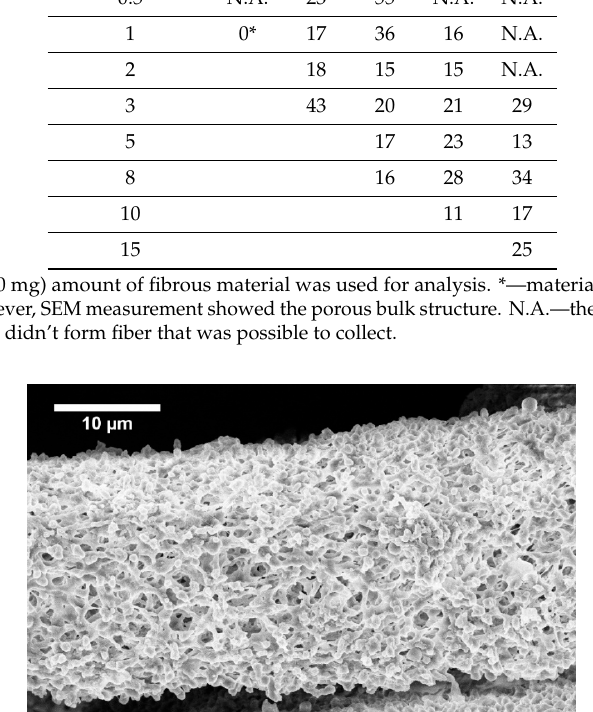
Table 1. Screening of specific surface areas of prepared samples (BET) [m 2 .g − 1 ]. Conc. (wt.%)